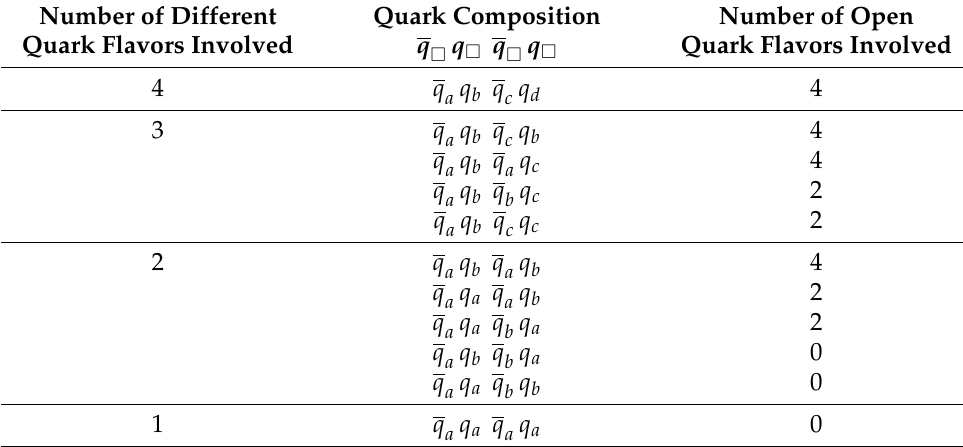
Table 1. Tetraquark states (3): Classification by different vs. open quark-flavor content a (cid:54) = b (cid:54) = c (cid:54) = d , open-flavor number referring to all flavors not counterbalanced by their antiflavors. (From Ref. [20]).